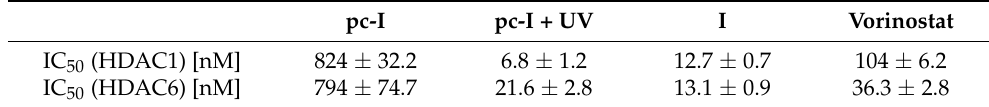
Table 1. Inhibitory activity of photocaged pc-I (with and without UV irradiation) and I against human HDAC1 and HDAC6 a .